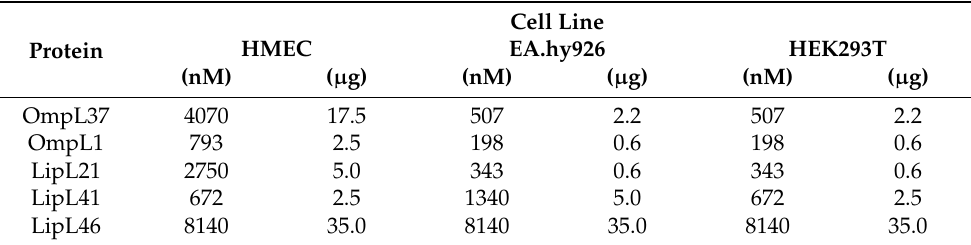
Table 2. Recombinant protein concentration (nM) and weight ( µ g) added to leptospire blocking assay in cell monolayers.